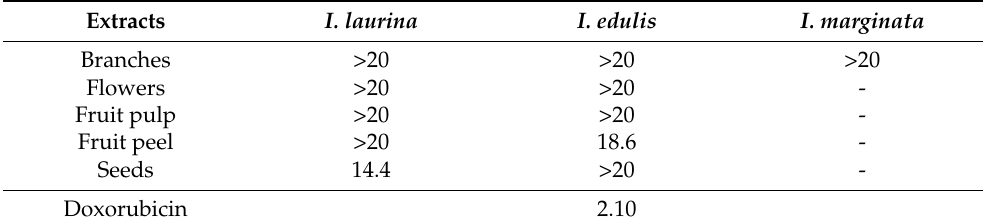
Table 2. Inhibitory concentration (IC 50 ; µ g mL − 1 ) values were obtained from the cytotoxic effect of the ethanolic extracts of the three Inga species against T98G human glioblastoma cancer cell